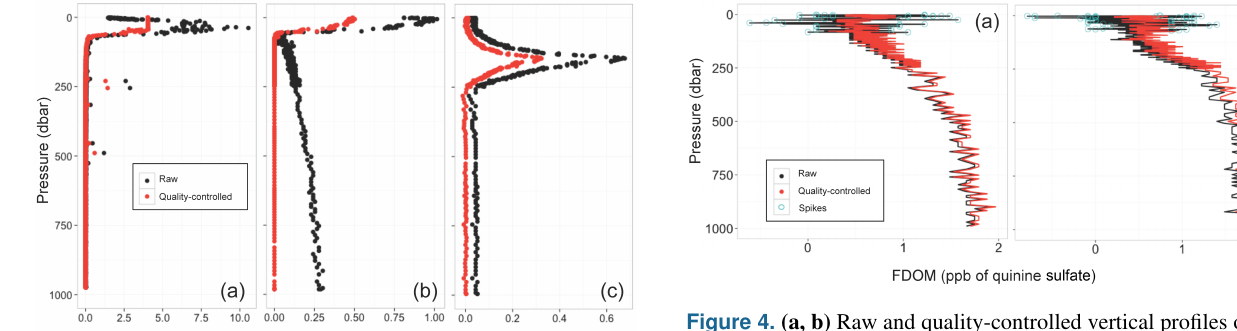
Figure 4. (a, b) Raw and quality-controlled vertical profiles of flu- orescent dissolved organic matter (FDOM, ppb of quinine sulfate) collected by the profiling float WMO 6901440 in the South Atlantic subtropical gyre. Open cyan circles indicate positive spikes for the raw profile. Both profiles were acquired within 1 week from the